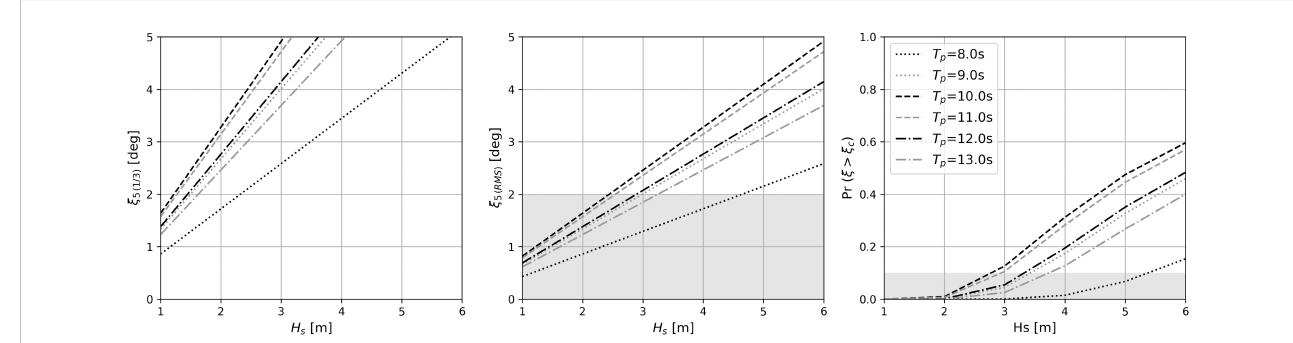
FIGURE 14 Statistics analysis in terms of signi fi cant ( x 5 (1/3) ) and RMS pitch ( x 5 (RMS ) of Body16, together with its probability of pitch motions exceeding 5deg for various H s with different T p .